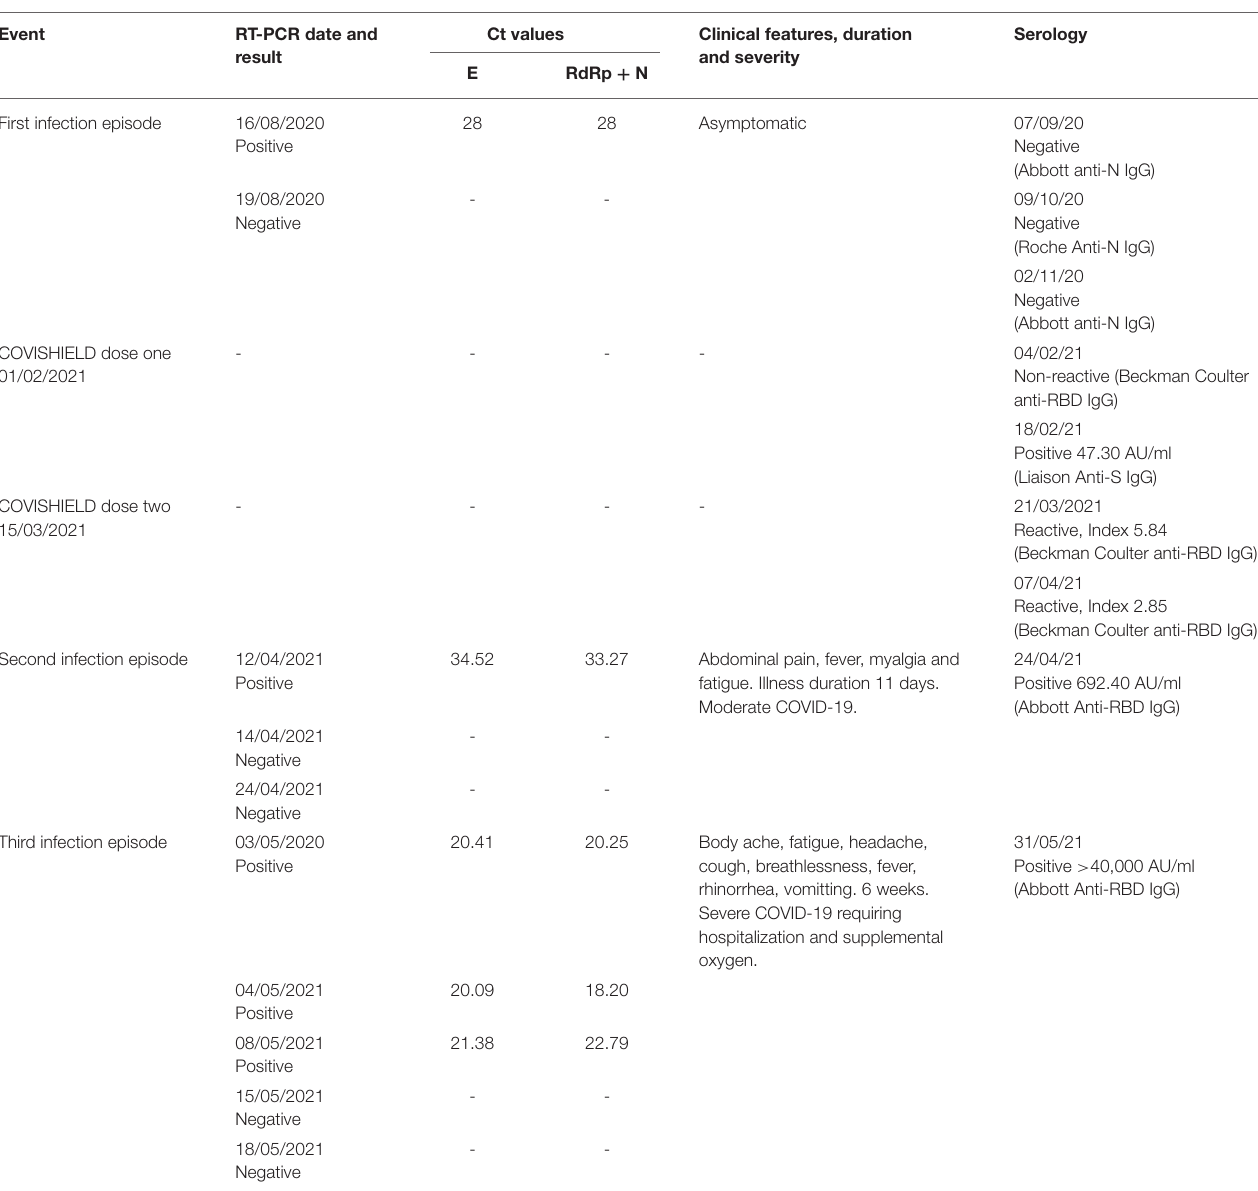
TABLE 1 | Clinical features, RT-PCR, Ct values, and Serology.